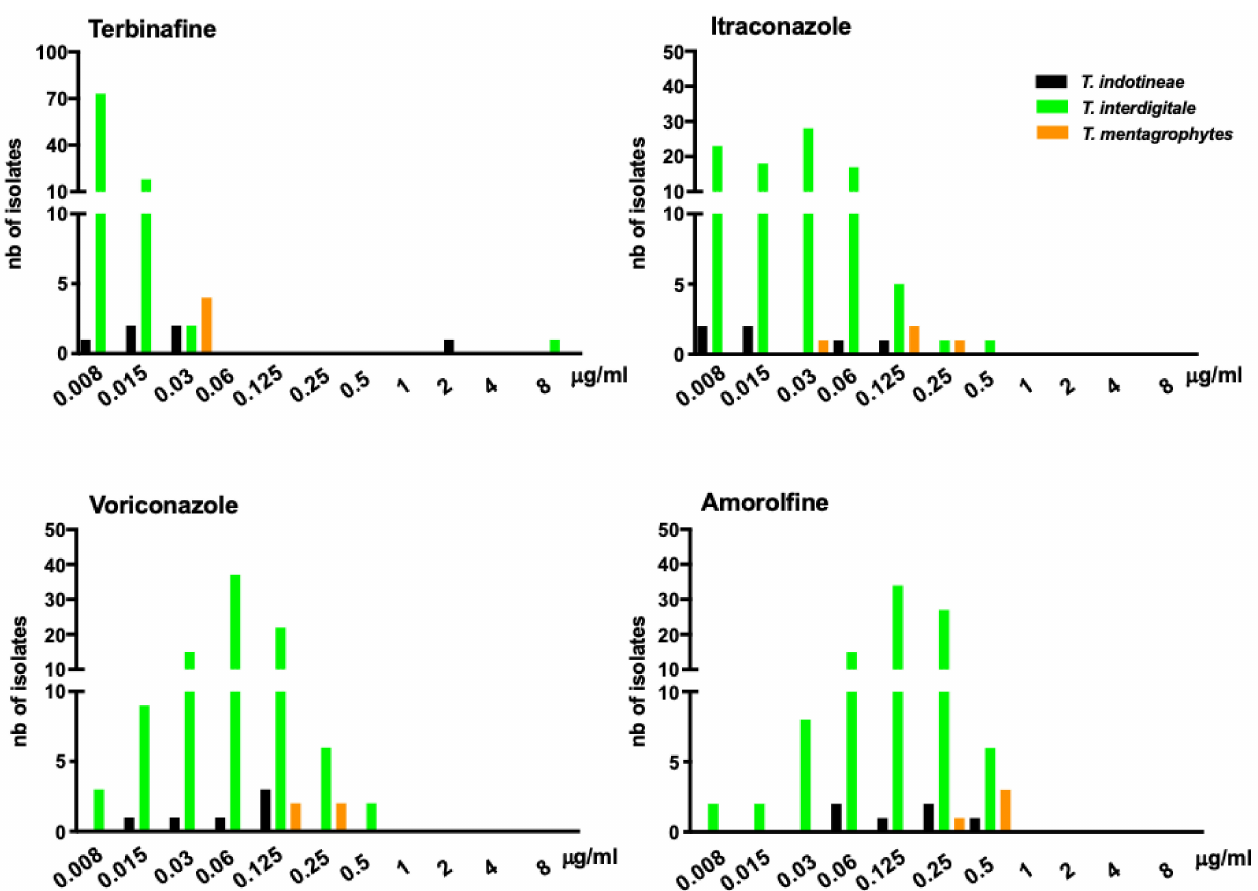
Figure 2. Distribution of terbinafine, itraconazole, voriconazole and amorolfine MIC values for 104 clinical isolates of T. indotineae , T. interdigitale and T. mentagrophytes collected in the Paris area, France. Terbinafine-resistant strains are limited to T. indotineae and T. interdigitale . MIC distribution shows that isolate population studied remains susceptible to the four antifungal drugs, despite the detection of two TerR isolates. T. indotineae n = 6; T. interdigitale n = 94; T. mentagrophytes n =